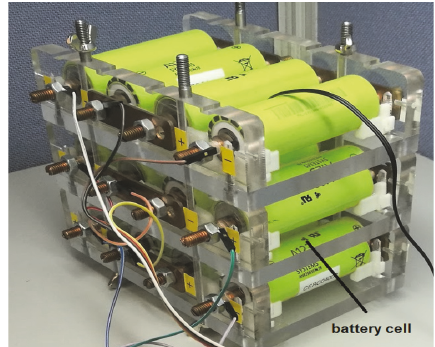
Figure 1: Proposed lithium iron phosphate battery prototype.